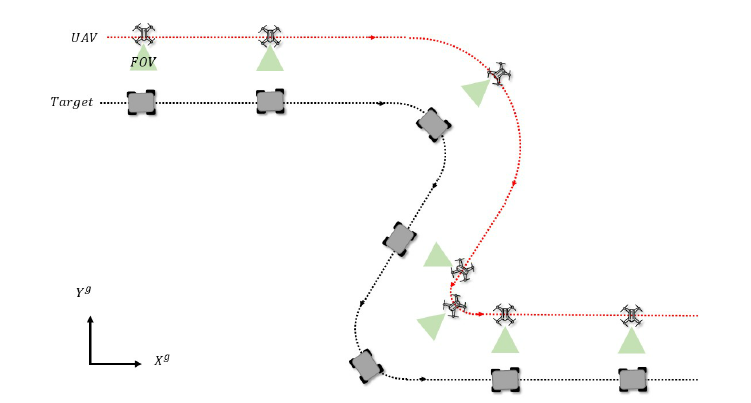
Figure 14. A UAV tracks a moving target moving over a z-shaped path. The trajectory of the target is unknown to the UAV. The target moves at 1 m/s in the heading direction from 3 s to 13 s, and first turns at − 0.2 m/s 2 from 13 s to 23 s. The target keeps moving at 1 m/s from 23 s to 33 s, and performed a second turn at 0.2 m/s 2 from 33 s to 43 s, and then keeps moving at 1 m/s.